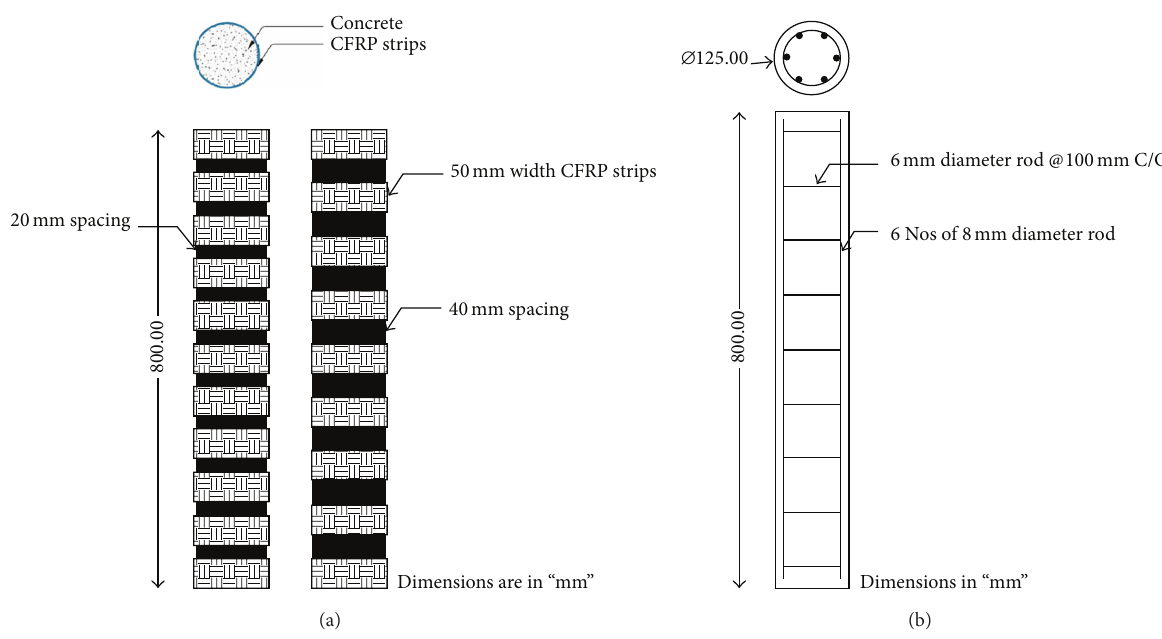
Figure 1: (a) CFRP strips wrapping scheme and (b) column reinforcement